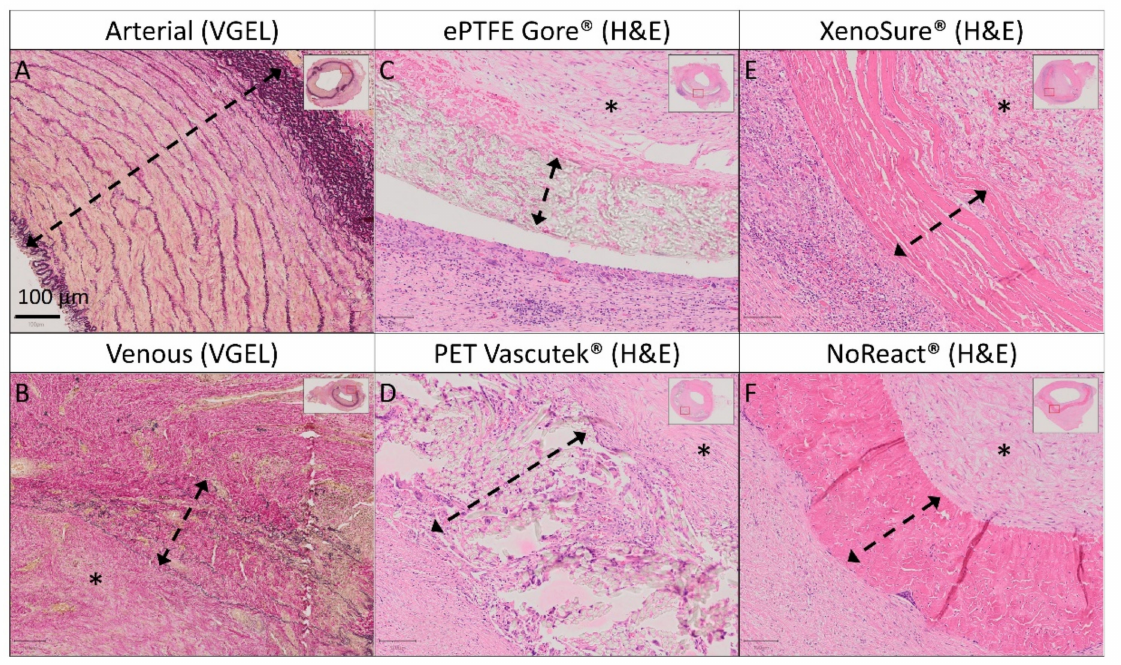
Figure 8. Detailed histology of control vascular patches in porcine carotid arteries 1 month post- implantation. We implanted two types of autologous patches: ( A ) arterial autografts and ( B ) venous autografts; two kinds of prosthetic patches: ( C ) expanded polytetrafluoroethylene (ePTFE, Propaten ® Gore ® ) and ( D ) polyethylene terephthalate (PET, Vascutek ® ); and two types of bioprosthetic patches: ( E ) bovine pericardium (BP) chemically stabilized with glutaraldehyde (XenoSure ® ) and ( F ) detoxified porcine pericardium (PP, BioIntegral ® NoReact ® ). Representative cross-sections of the midgraft regions are shown. We performed staining with hematoxylin and eosin (H&E) and Van Gieson Elastica. A double arrow denotes the implanted patch material, and an asterisk denotes the luminal side of the patch and neo-intimal tissue (magnification 20 ×